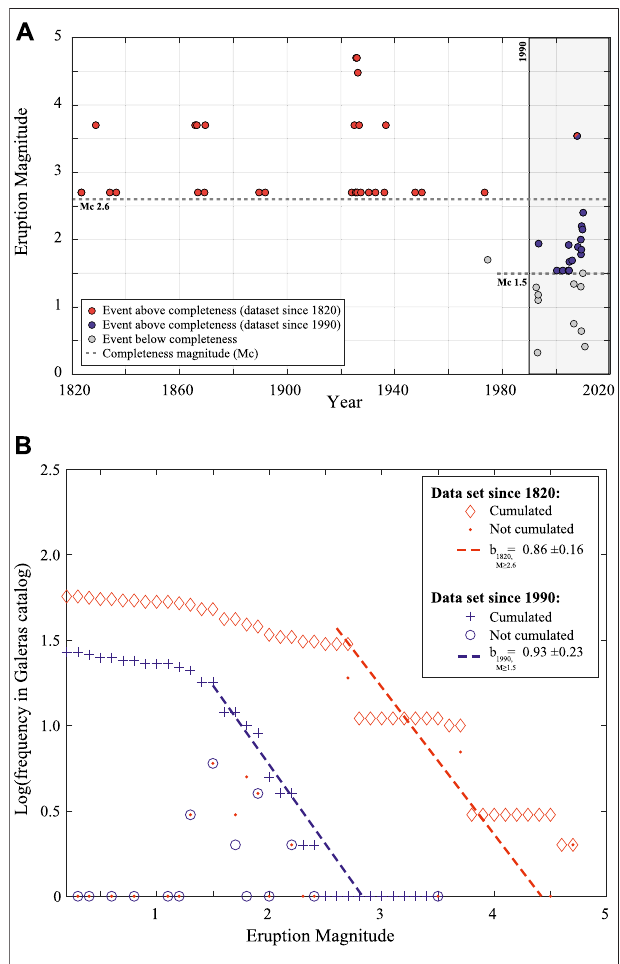
FIGURE 3 | Frequency-size analysis: in red the S1 data (see text), i.e., from 1820, M ≥ 2 . 6; in blue S2, i.e., from 1990, M ≥ 1 . 5. In panel A we show the two datasets used (gray points are not used as they are below the completeness threshold); in panel B red dots and diamonds show respectivelythenot-cumulativeandcumulativeoccurrencesforS1data,while blue circles and plus signs respectively show not-cumulative and cumulative occurrencesforS2data.Thebest fi tting b -valuelinesaresuperimposedtothe cumulative data, although they have been computed on the not-cumulative ones for an unbiased